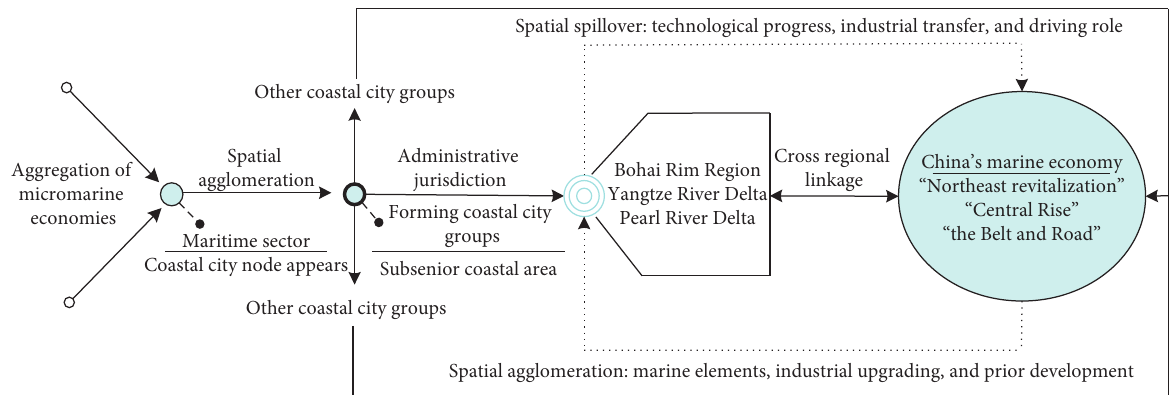
Figure 5: Spatial features of the high-quality development of China’s marine